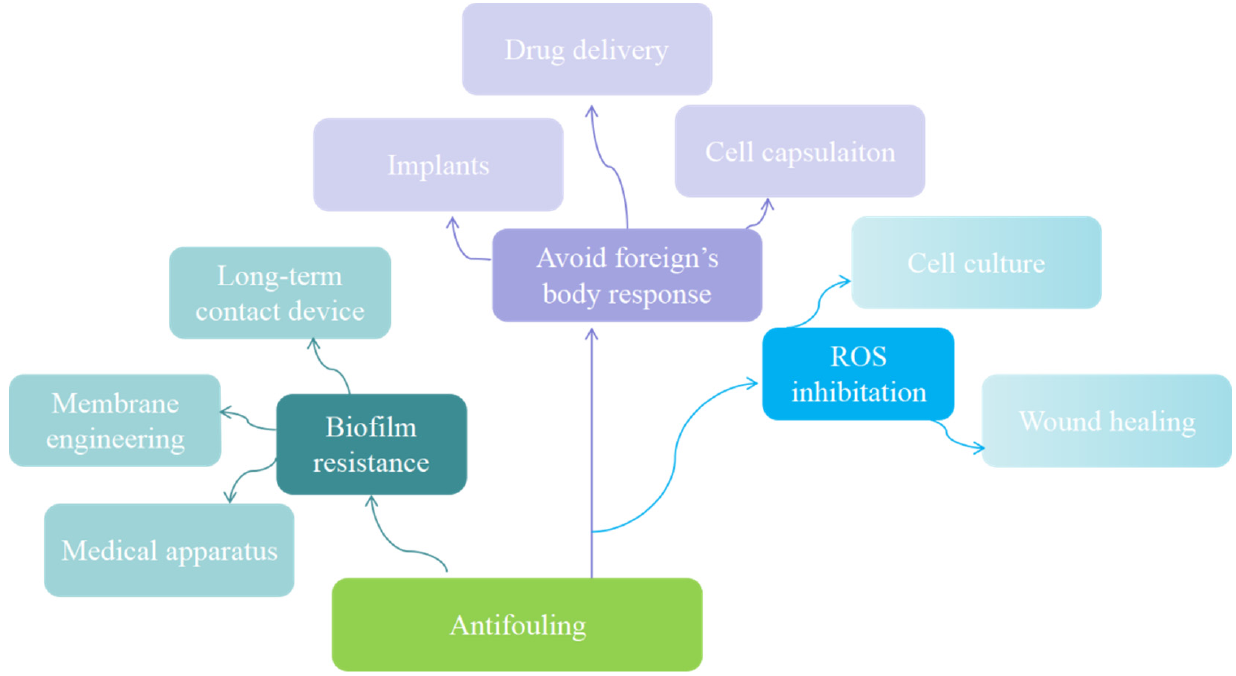
Figure 10. Application of antifouling zwitterionic hydrogel.